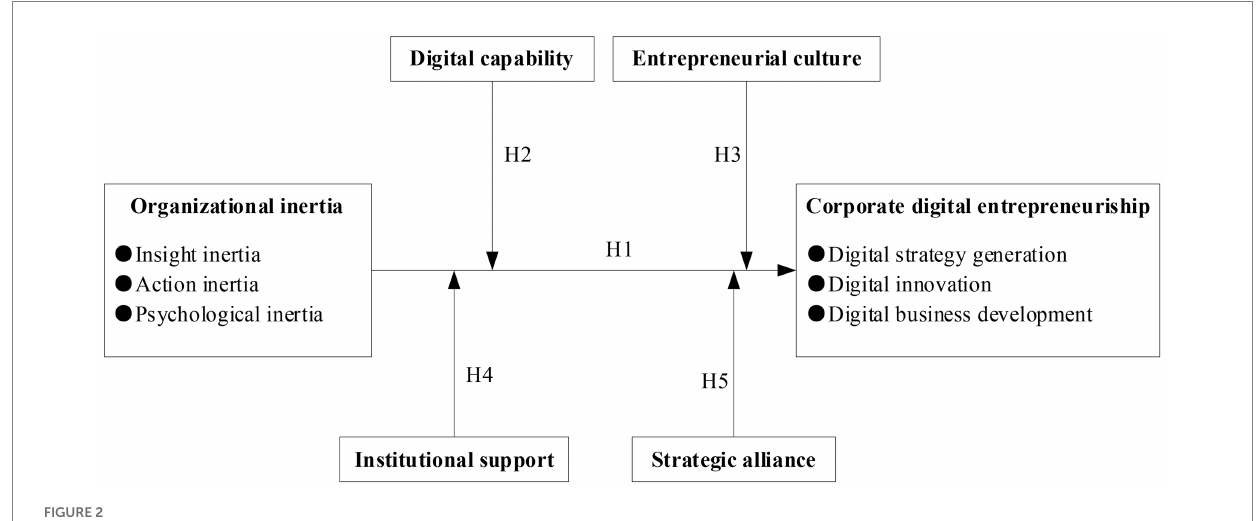
FIGURE 2 Theoretical